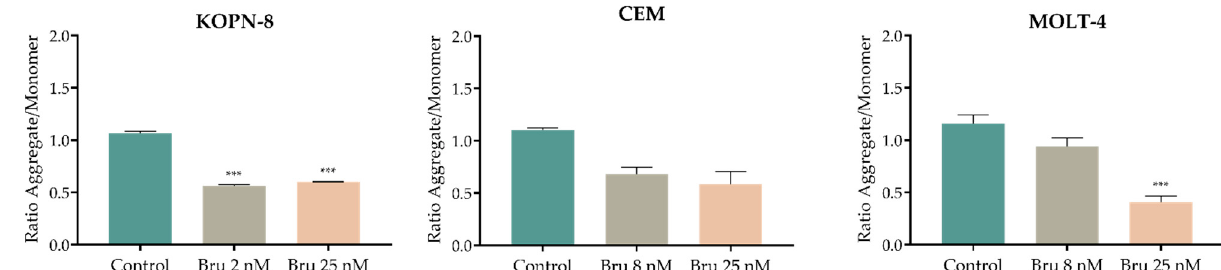
Figure 7. Analysis of mitochondrial membrane potential ( ∆ ψ mit ) in acute lymphoblastic leukemia cell lines treated with brusatol. ∆ ψ mit was measured using JC-1 fluorescent probe by flow cytometry. Results are expressed in mean ± SEM of aggregate (A)/monomer (M) ratio of JC-1 and this ratio was calculated as the fraction of mean fluorescence intensity (MFI) observed for each molecule. *** p < 0.001 compared with untreated cell (control).